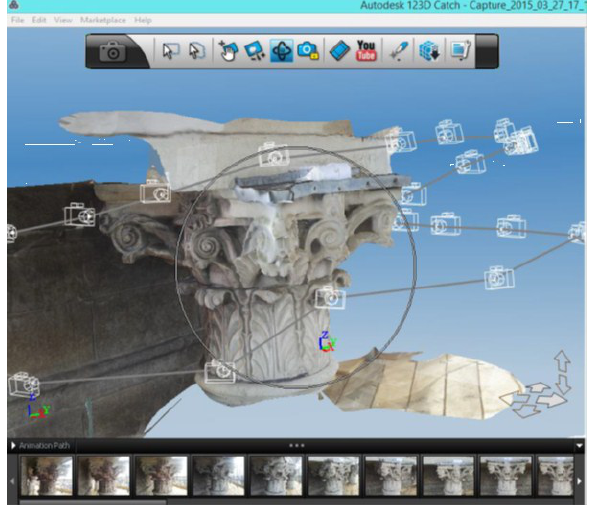
Figure 8: Point Cloud